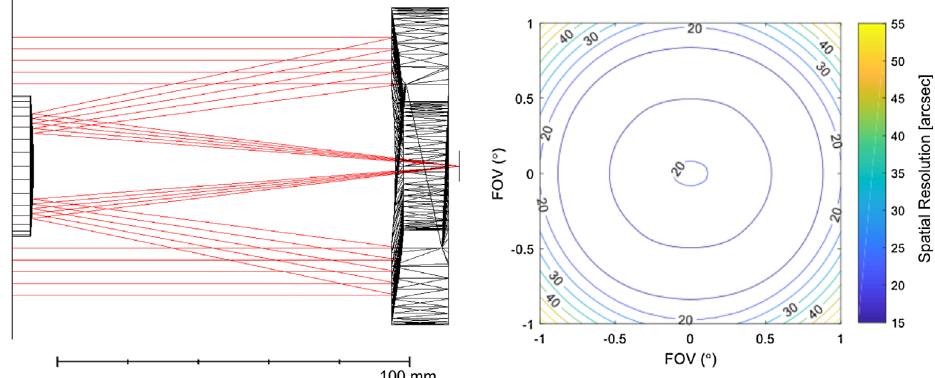
Fig. 9. Left: Ray trace of SunCET optics. Right: 80% encircled spot diameter over the FOV. This simple design yields excellent performance, with a mean resolution of 20 that is fl at across nearly the entire